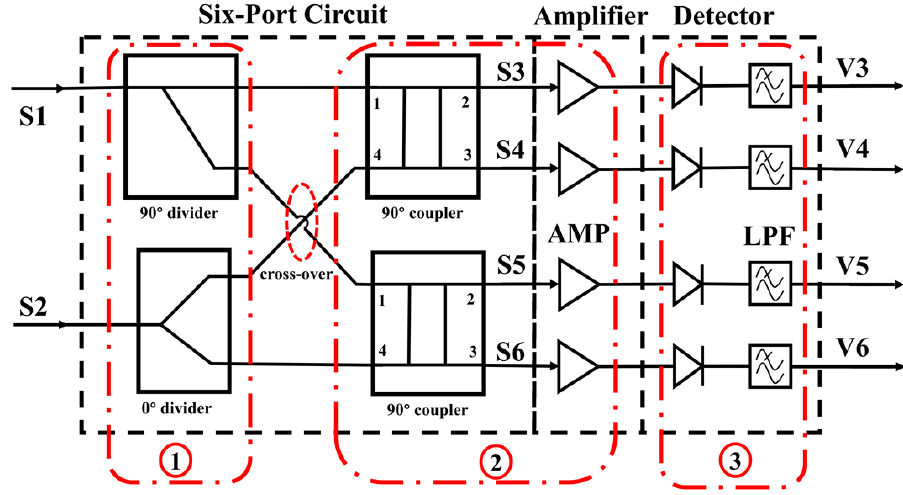
Figure 1. The block diagram of the proposed analog correlator.